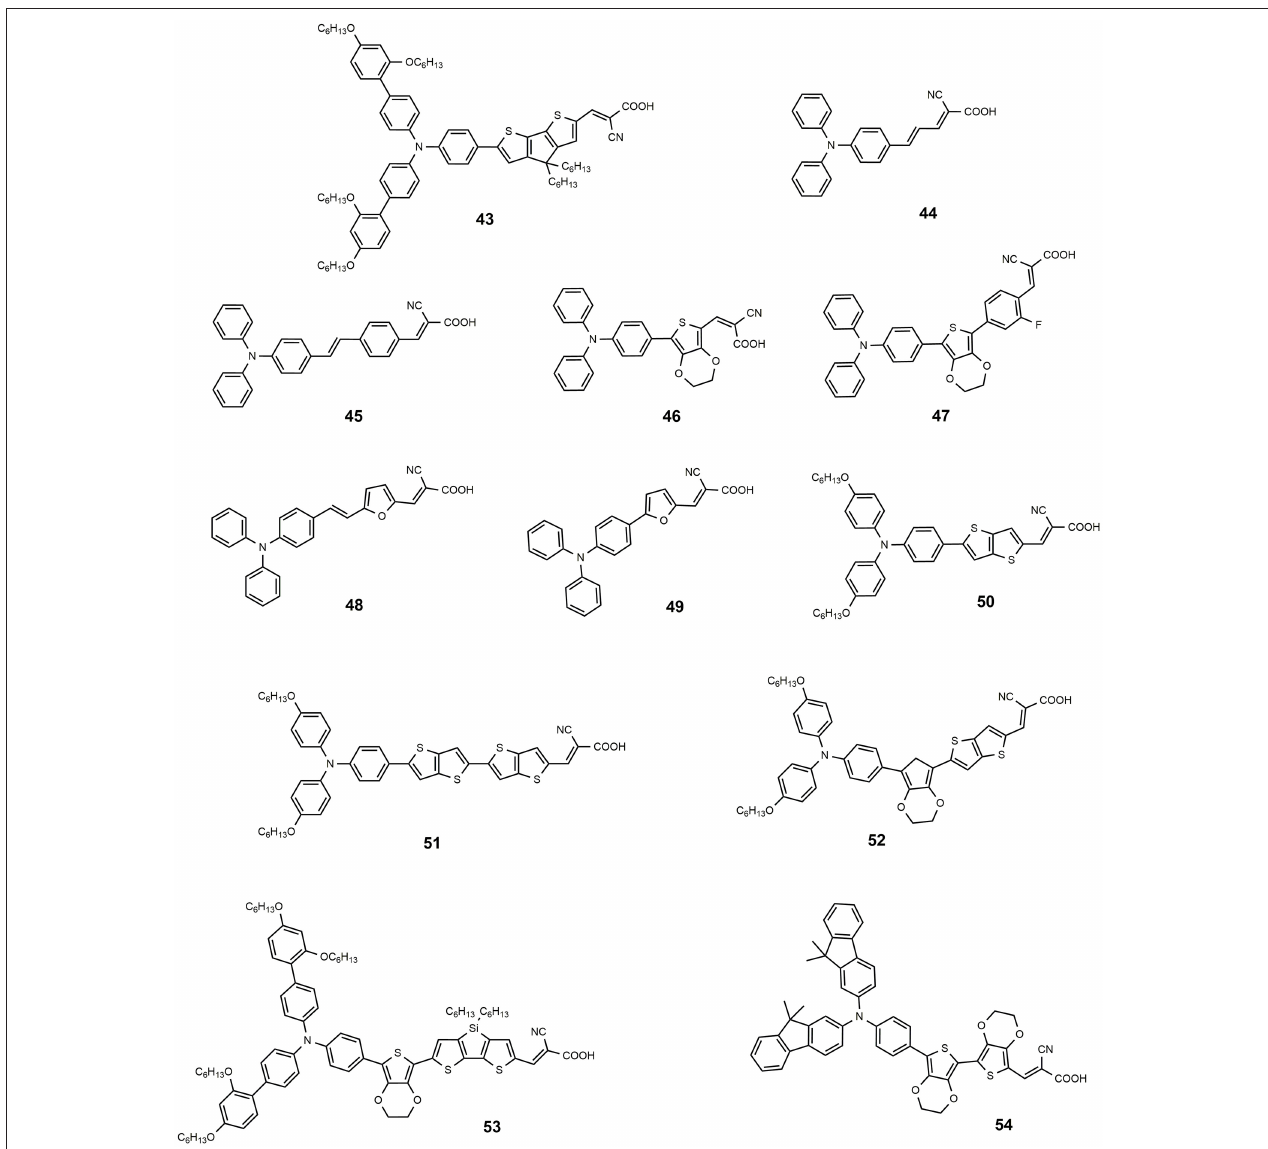
FIGURE 7 | Chemical structures of dyes